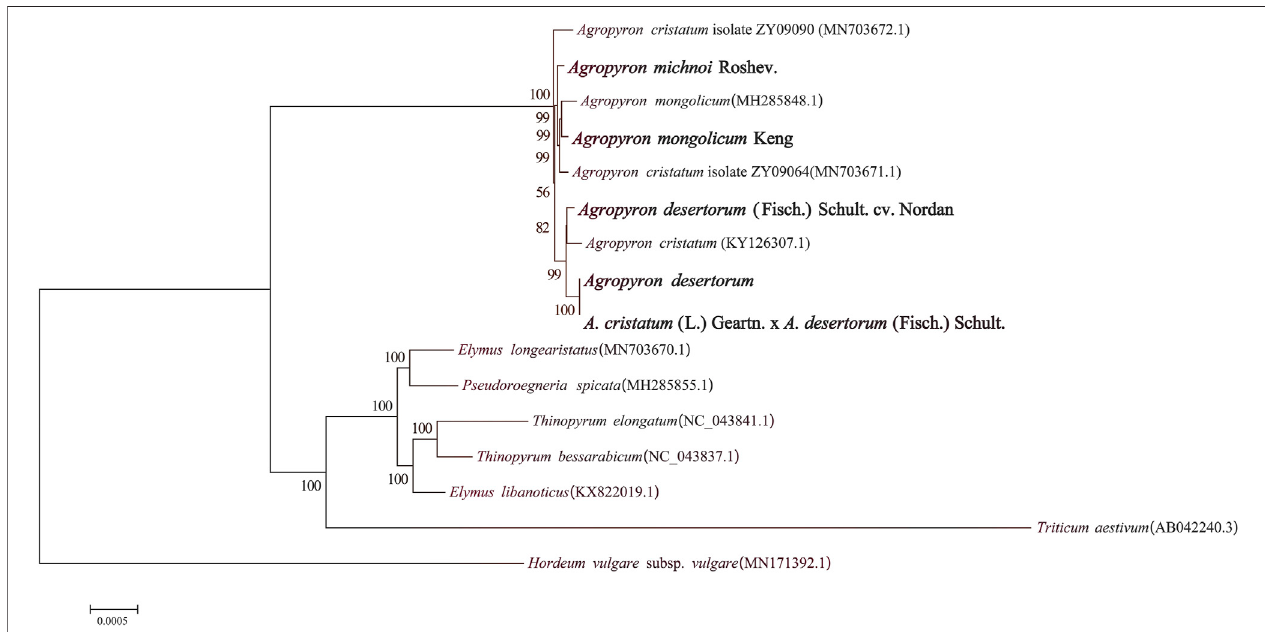
FIGURE 9 | Phylogenetic tree of fi ve species of Agropyron and related taxa based on the complete chloroplast genomes.